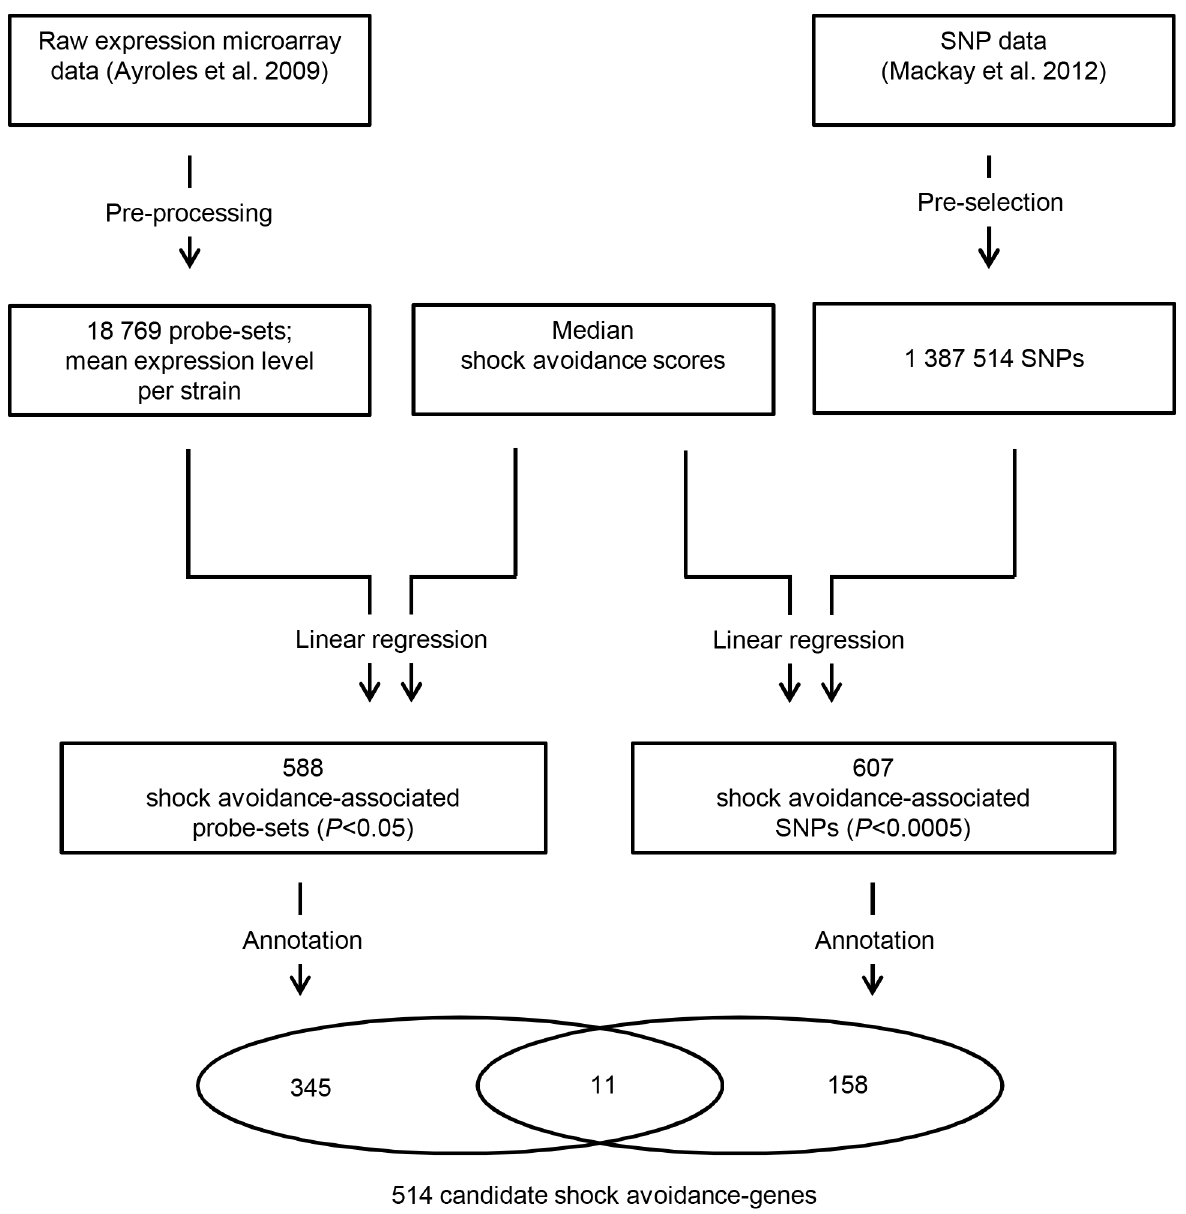
Fig 2. Genome-wide association analyses for shock avoidance. On the left, the gene expression level — shock avoidance association analysis is sketched. After pre-processing the raw expression microarray data, for each of the 18 769 probe-sets, we tested for a linear relationship across strains between the mean expression levels and the median shock avoidance scores. This analysis suggested 588 shock avoidance-associated probe-sets (linear regression P < 0.05; see S1 Table for a list with full statistical reports), corresponding to 356 candidate genes (see S4 Table for a list). On the right, the single nucleotide polymorphism (SNP) — shock avoidance association analysis is shown. We narrowed down our analysis to pre-selected SNPs with favourable minor allele frequencies and call rates. Testing for relationships between the allele types and the shock avoidance scores suggested 607 shock avoidance- associated SNPs (linear regression P < 0.0005; see S2 and S3 Tables for a list with full statistical reports), pointing to 169 candidate shock avoidance-genes (see S4 Table for a list), 11 of which were already suggested by the expression